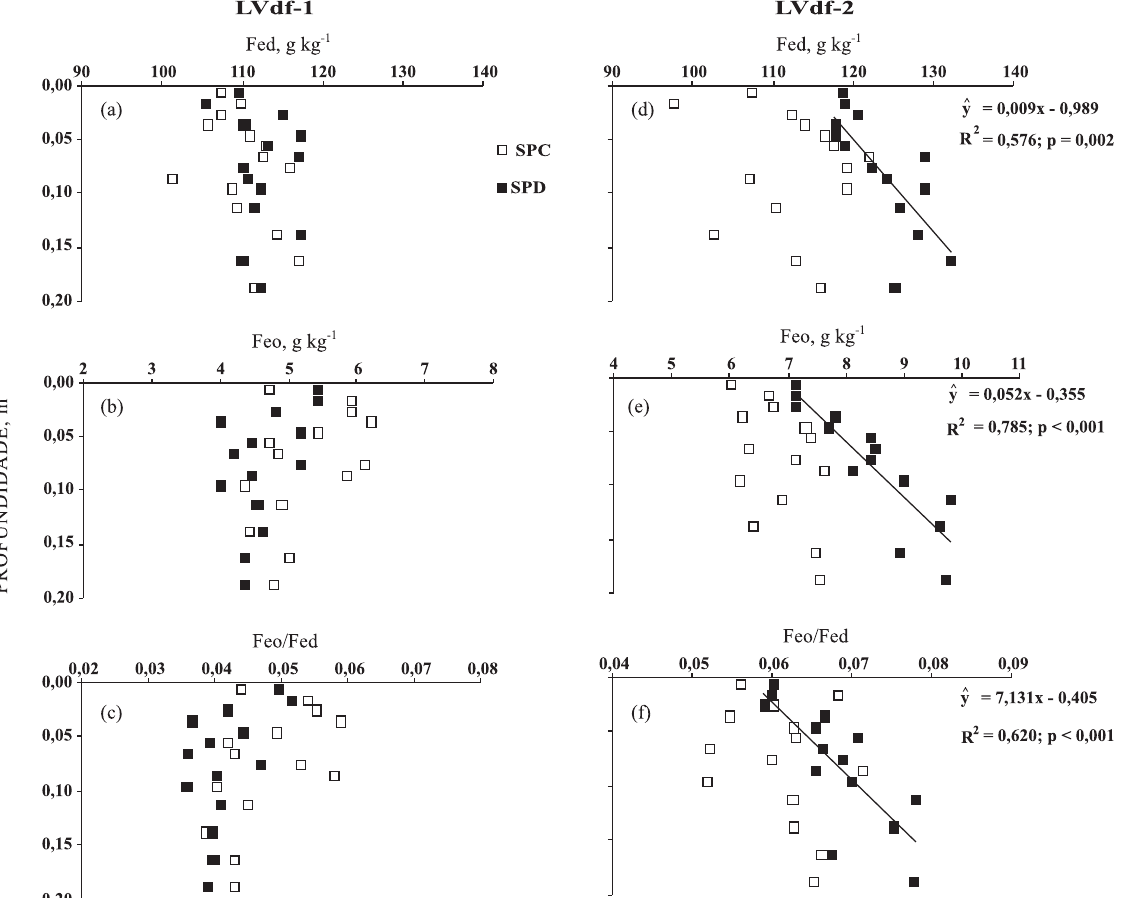
Figura 2. Teores de óxidos de ferro cristalinos (Fed), de óxidos de ferro de baixa cristalinidade (Feo) e a razão Feo/Fed da fração argila ao longo da camada superficial dos solos LVdf-1 (a, b, c) e LVdf-2 (d, e, f), em sistema de preparo convencional (SPC) e sistema plantio direto